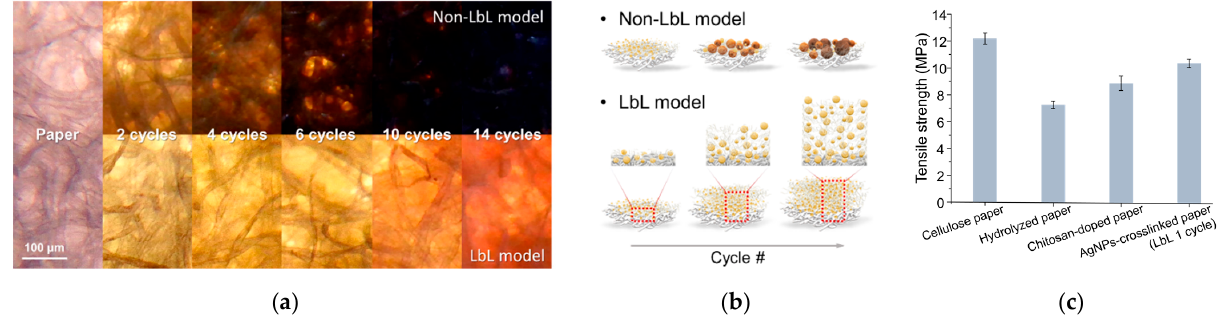
Figure 2. ( a ) Optical micrographs of LbL and non-LbL paper that underwent the fabrication process for 14 cycles, representing the effects of chitosan on colloidal stability; ( b ) Illustration showing how chitosan oligomer prevents the aggregation of particles during the LbL process; ( c ) Changes in the tensile strength of the substrate when proceeding with each step, implying mechanical enhancement by chitosan self-assembly and crosslinks with silver